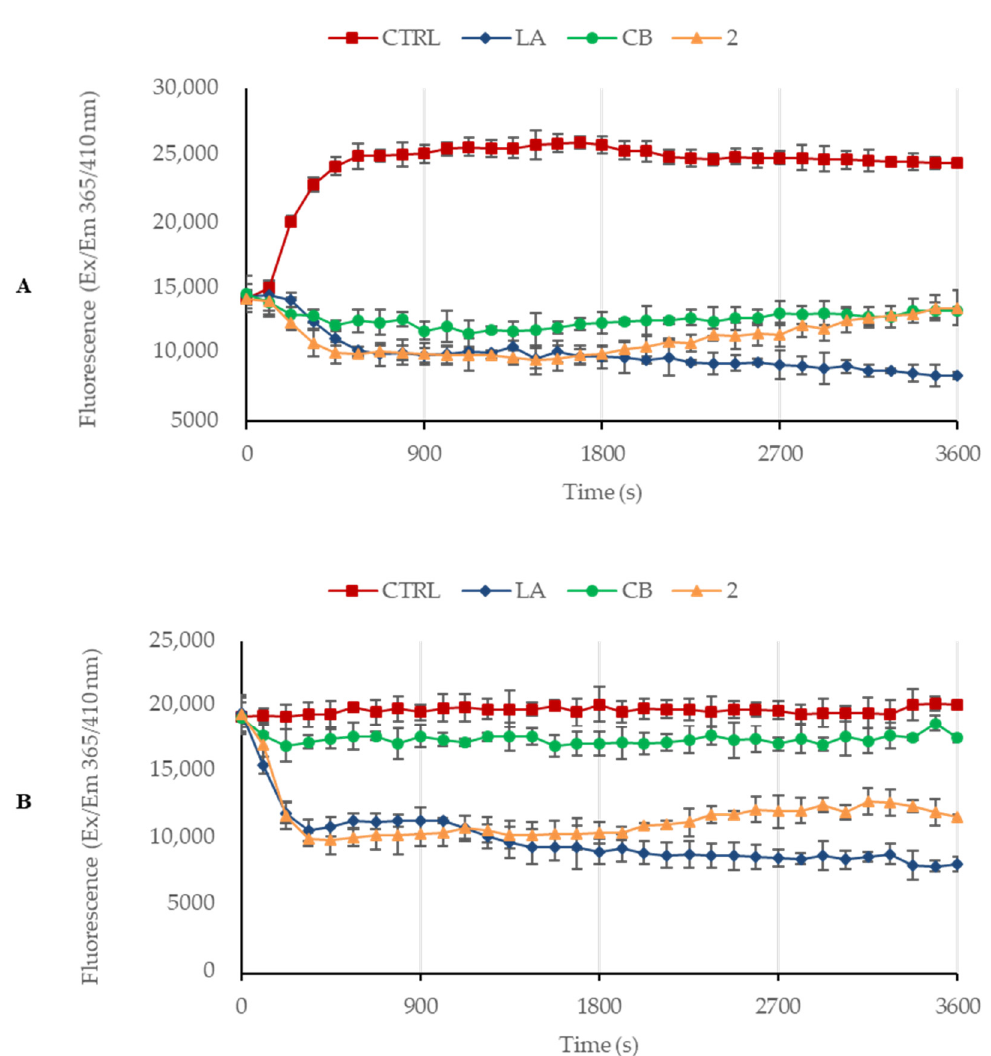
Figure 7. ( A ) In vitro actin polymerization assay and ( B ) in vitro actin depolymerization assay. For both the assays, derivative 2 was used at the concentration of 10 µM, DMSO was used as a negative control, while actin-targeting agents, LA and CB (5 µM), were used as reference molecules. The formation of the actin filaments was measured with a microplate reader recording the fluorescence ( λ ex/em : 365/410 nm) in kinetic mode for 1 h. The graphics are representative of three separated tests; standard deviations (SDs) are shown.